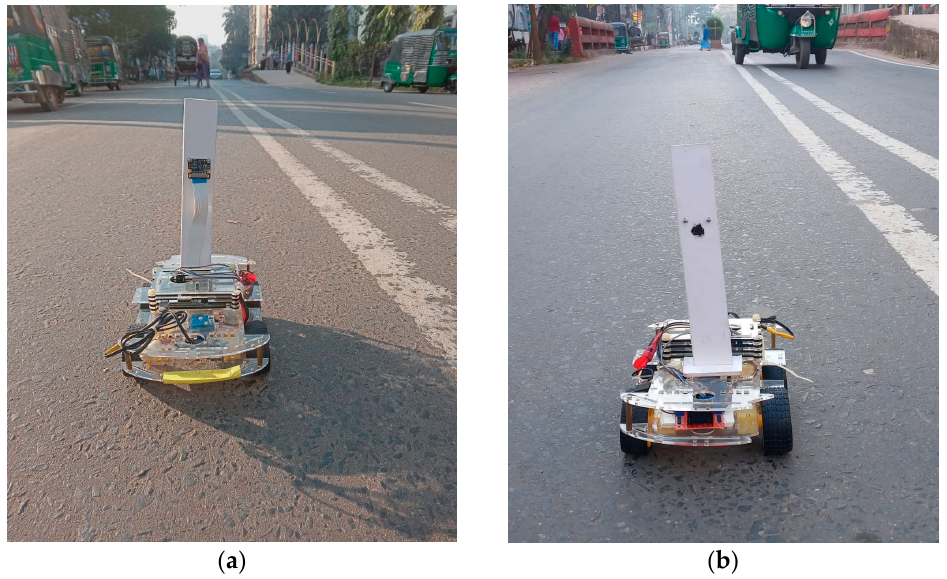
Figure 21. The performance of the car in the various environment ( a ) in lightening atmosphere ( b ) in a cloudy atmosphere. a cloudy